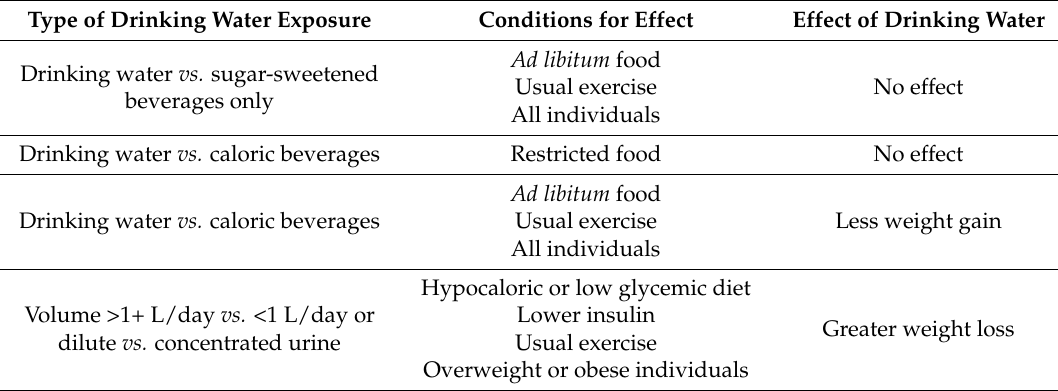
Table 8. Long-term effects of drinking water on weight by type of exposure and RCT